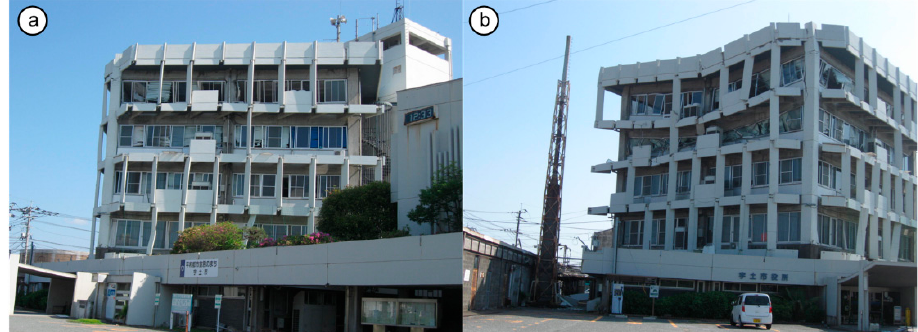
Figure 5. View of Uto City Hall after the 2016 Kumamoto Earthquake: ( a ) south (frame A 3 ) and ( b ) southwest (frames A 3 and B 1 ).